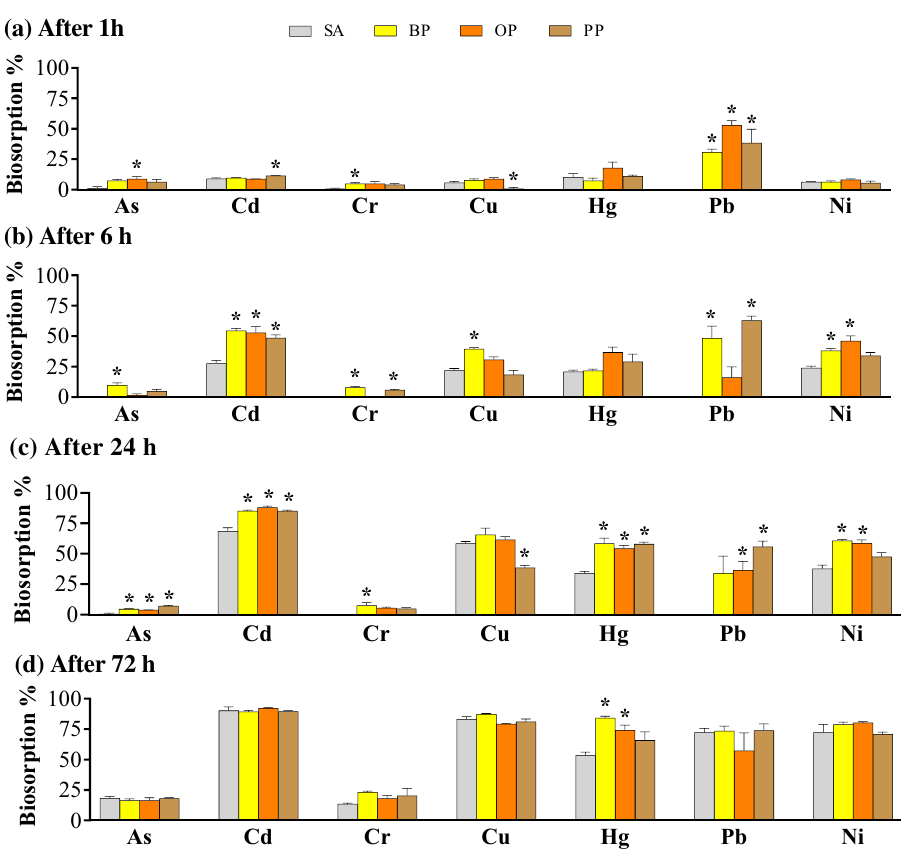
Fig. 5 Temporal biosorption of FVP and SA beads. One bead was incubated in a cocktail solution containing all seven ions each at 0.1 mgL-1, pH 7.0, 25 °C with continuous shaking at 250 rpm for 15 min–72 h. *Significantly different biosorp- tion compared to the corre- sponding SA bead, p < 0.05. The bars represent mean ± SE for N = 3; data analysis by one- way ANOVA with a Bonferroni post hoc test. a 1 h, b 6 h, c 24